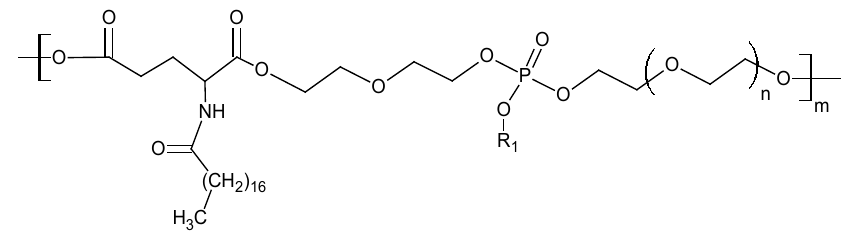
Figure 2. The structural formula of the polyphosphate ester.